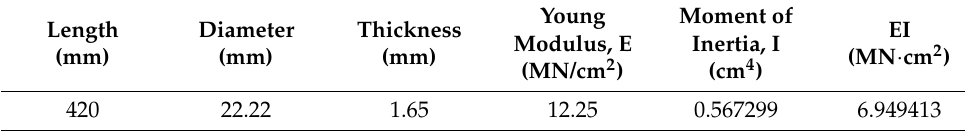
Table 3. Properties of model